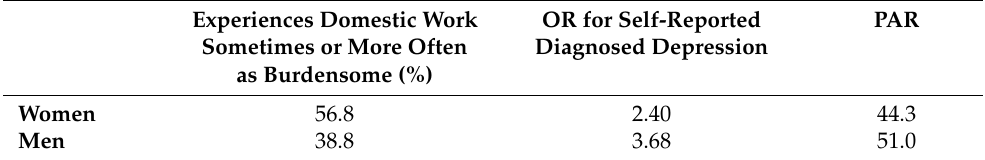
Table 3. Prevalence (%) of burdensome domestic work, odds ratio (OR) and population attributable risk (PAR) for self-reported diagnosed depression among women and men aged 30–69